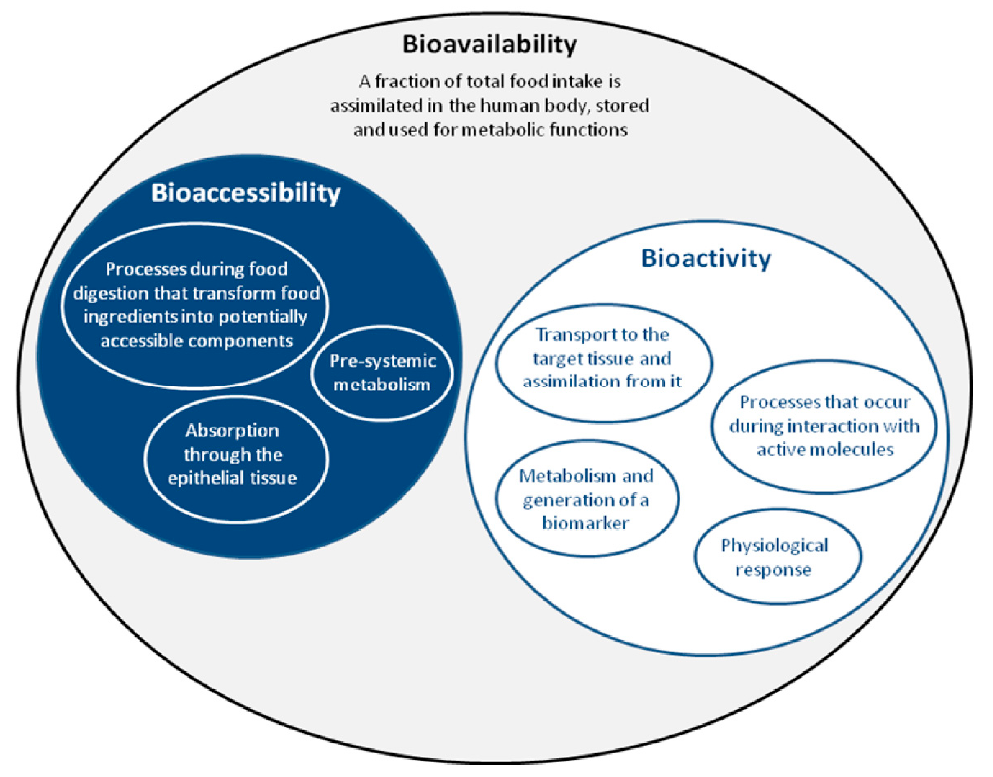
Figure 1. Bioavailability is defined as the synthesis of bioaccessibility and bioactivity, followed by different physicochemical processes. Adapted from Fernández-García et al. [38].